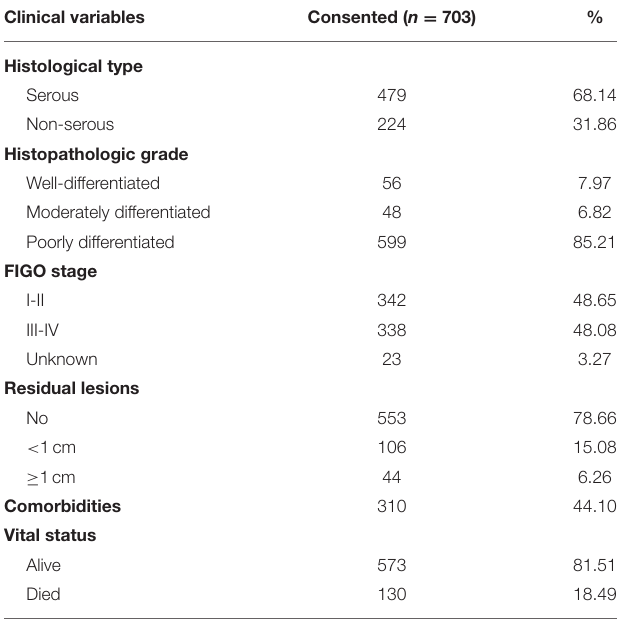
TABLE 6 | Previous results for ovarian cancer survival in the OOPS